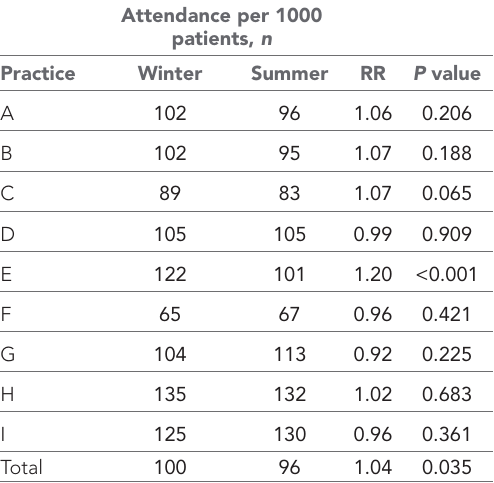
Table 1 A&E attendance per 1000 patients. Also shown is the relative risk of A&E attendance